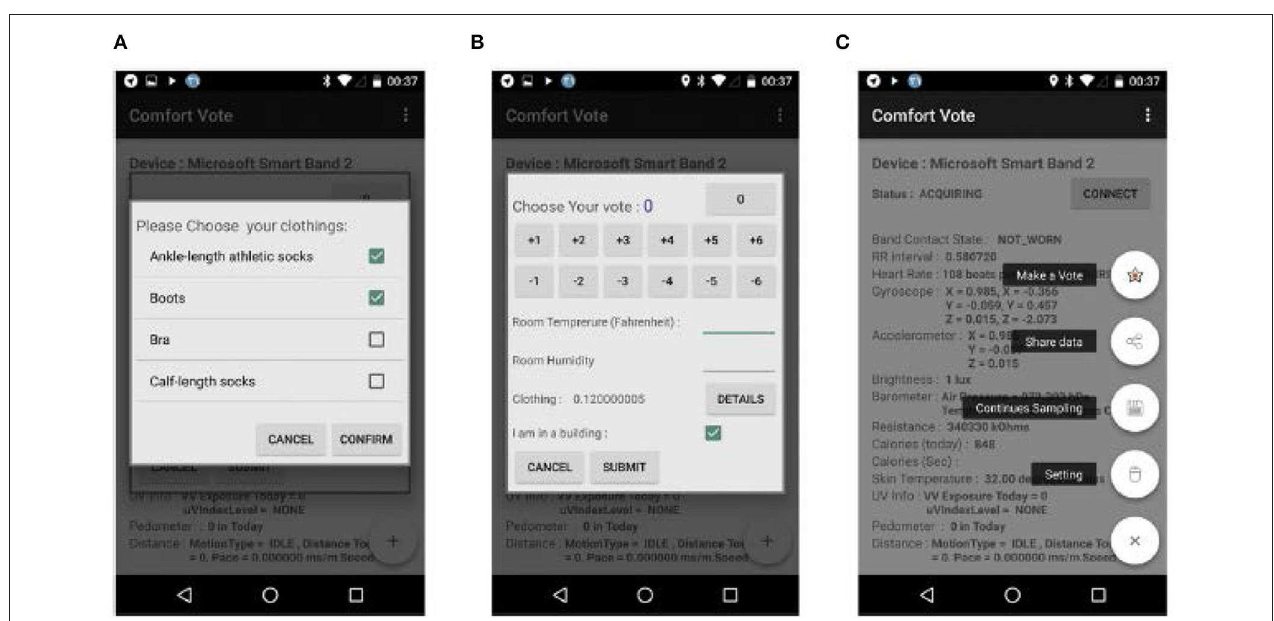
FIGURE 4 | The Comfort Vote mobile application showing screenshots of (A) collecting the clothing information. (B) Displaying the voting page. (C) The available options in the application.